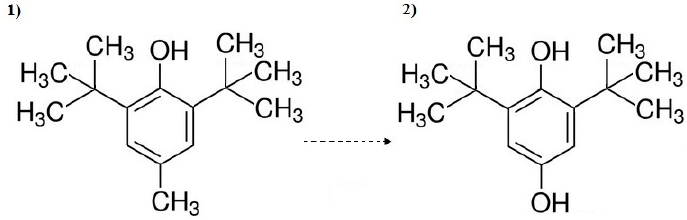
Figure 17. Identification of 1, butylated hydroxytoluene by-product, where 2 is 2,6-di-tert-butylhydroquinone.